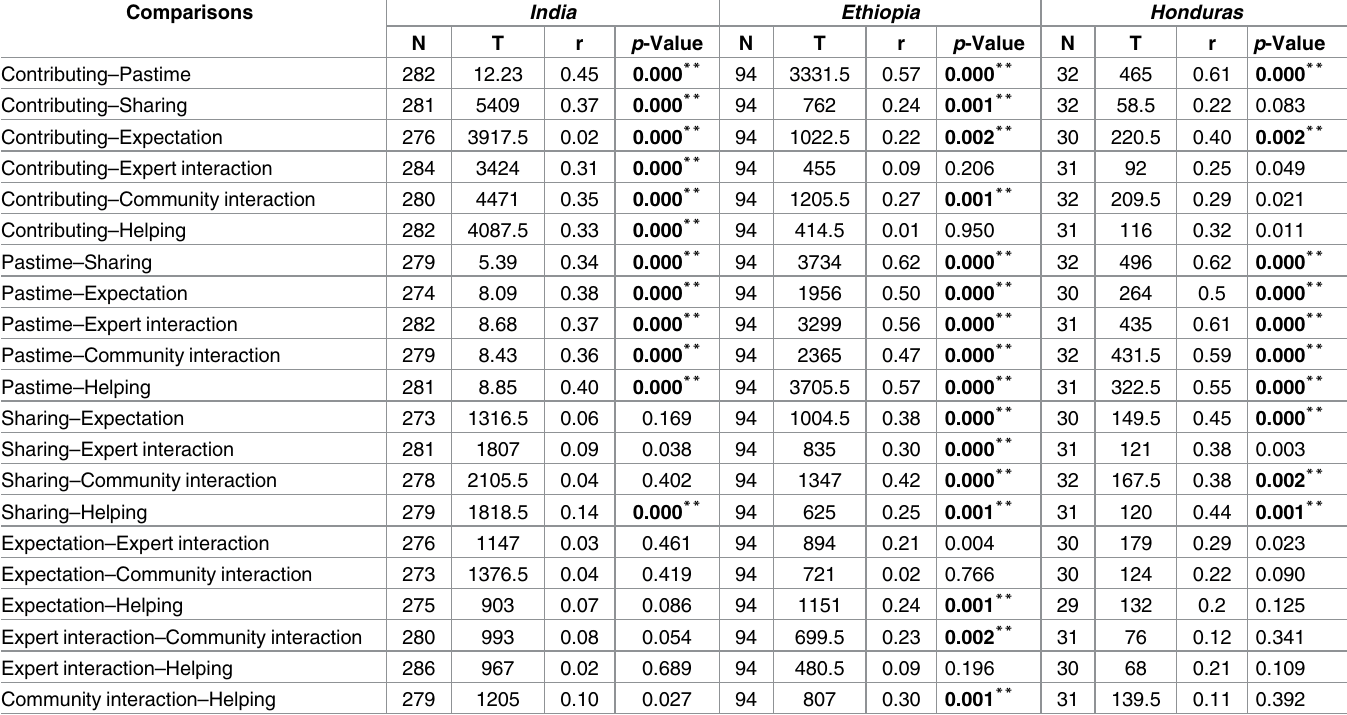
Table 3. Differencesof the motivational factors of farmerswithin each of the three countries’ using Friedman’s test and post-hoc Wilcoxon signed-rank test. For codes of motivational factors see Table 1.